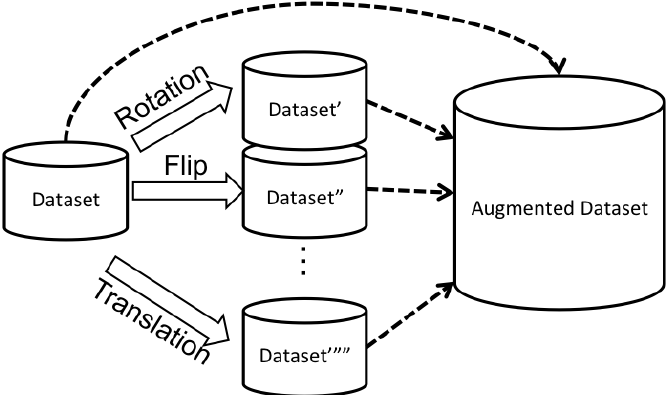
Figure 10. Data augmentation approach to enlarge the training dataset (ground-truth). The augmented dataset is composed of the original dataset together with its rotated, flipped or translated versions.